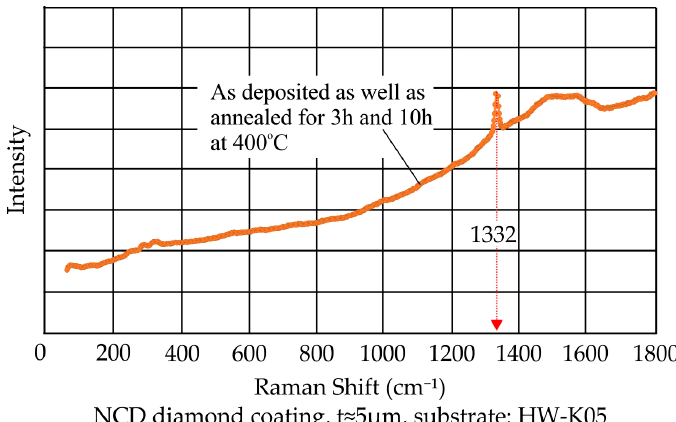
Figure 1. Raman spectra of the as deposited as well as the annealed at di ff erent conditions diamond coatings for investigating their crystallinity.